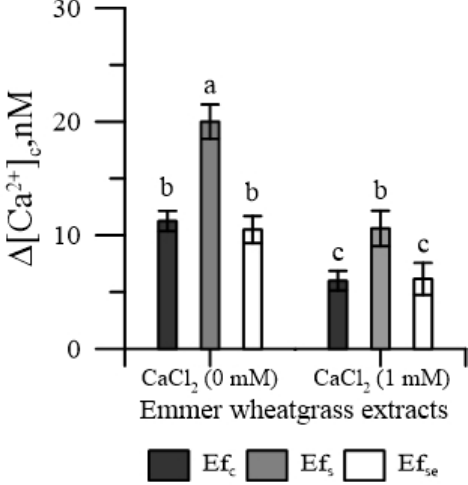
Figure 1. Effects of 50 mg of free extracts (Ef) of emmer wheatgrass obtained with distilled water as a control (Ef c ), or with NaCl (Ef s ) 50 mM or Na 2 SeO 3 0.45 mg L − 1 (Ef Se ), on the cytosolic Ca 2+ of maize pollen. The measurements were carried out in the absence of Ca 2+ and in the presence of Ca 2+ (1 mM CaCl 2 ) in the incubation medium. Data are expressed as means ± SEM from four independent tests. Different letters indicate significant differences for p < 0.05.